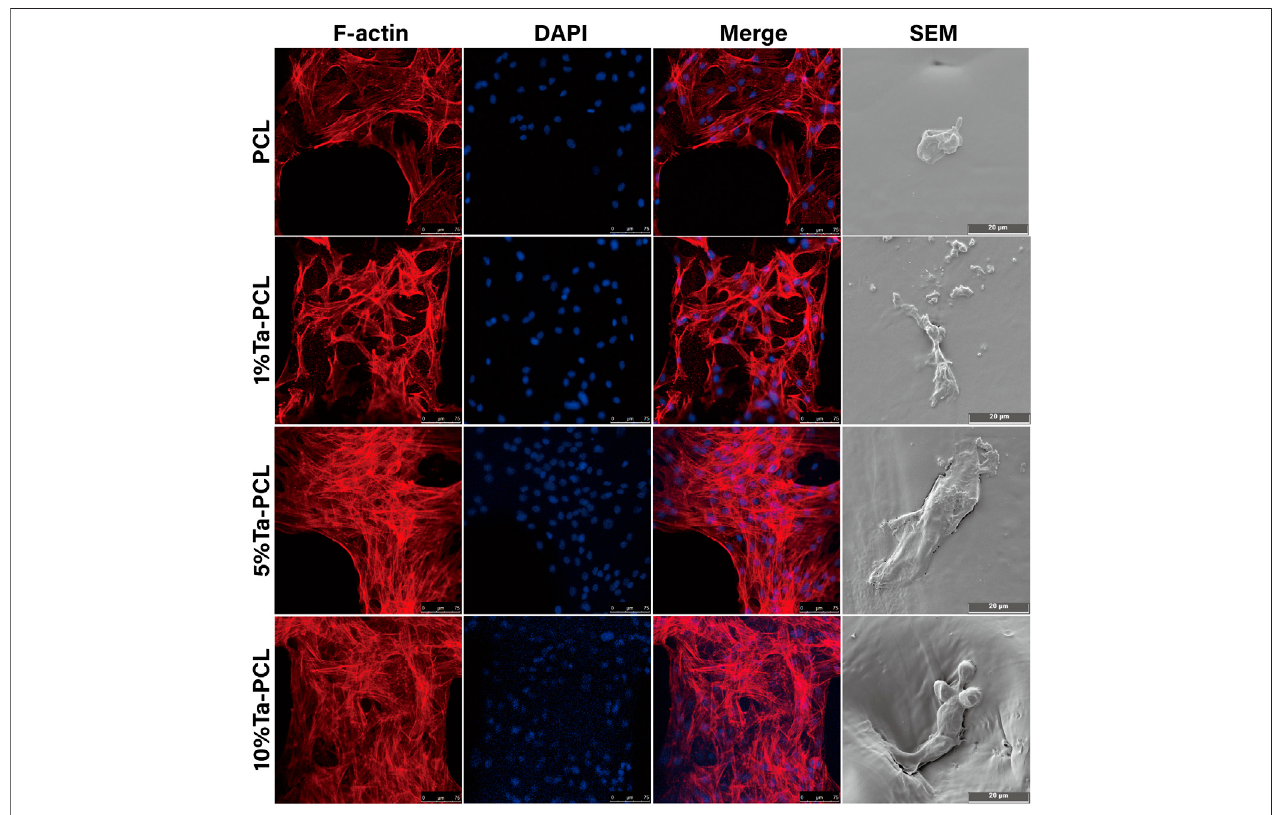
FIGURE 4 | Cell adhesion of Ta/PCL scaffold. Cytoskeleton of MSCs cultured on the scaffold for 5 days.